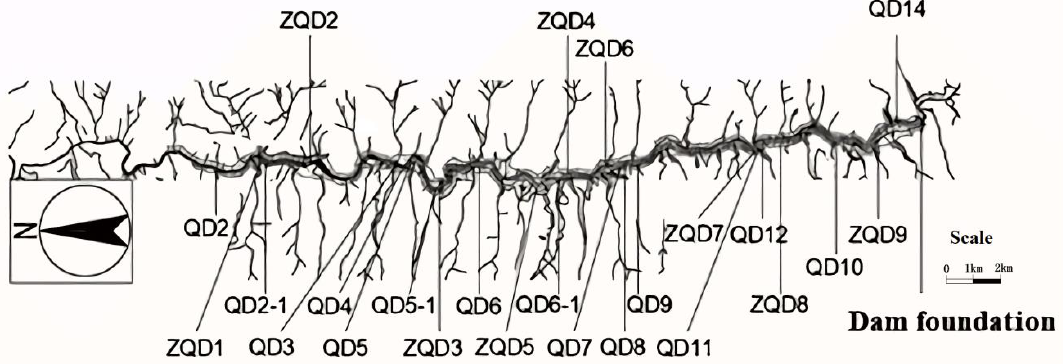
Figure 1. The distribution of toppling deformation body locations in the reservoir area.